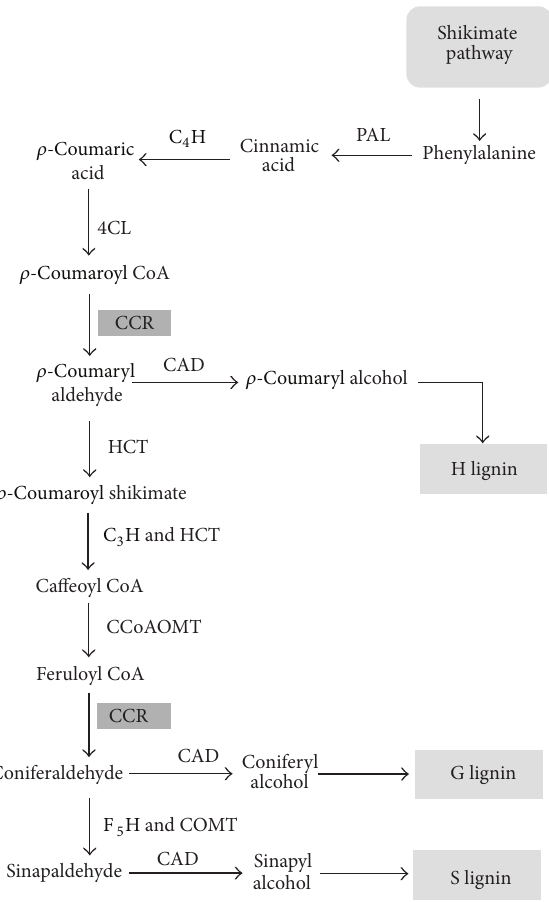
Figure 1: Monolignol biosynthetic pathway in dicotyledonous angiosperms. PAL, phenylalanine ammonia-lyase; C4H, cinna- mate 4-hydroxylase; 4CL, 4-coumarate: CoA ligase; HCT, p - hydroxycinnamoyl-CoA: quinate shikimate p -hydroxycinnamoyl- transferase; C3H, p -coumarate 3-hydroxylase; CCoAOMT, caffeoyl- CoA O -methyltransferase; CCR, cinnamoyl-CoA reductase; CAD, cinnamyl alcohol dehydrogenase; COMT, caffeic acid O -methyl- transferase; F5H, ferulate 5-hydroxylase. Modified from Godfrey Neutelings (2011)